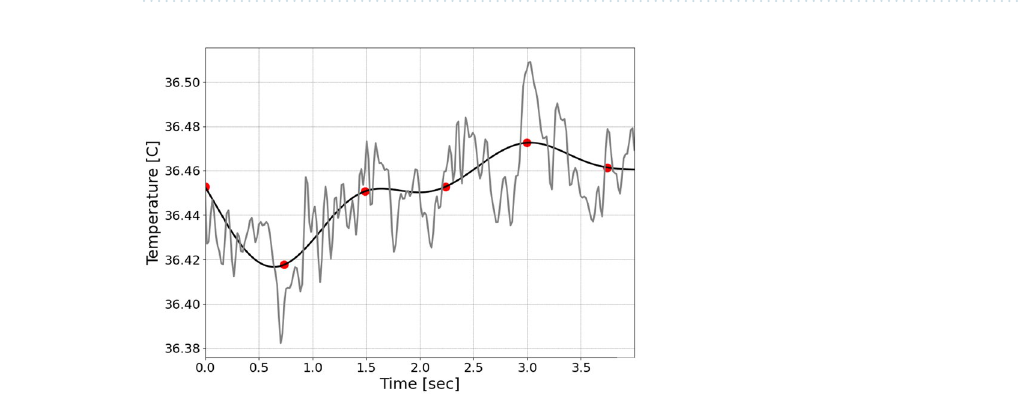
Figure 12. Forehead pixel temporal signal of the LWIR channel (grey line), low-pass filtered at 0.75 Hz (black line) and the temporally downsampled values (red dots), which become Feature 1, or F1 ( TMP